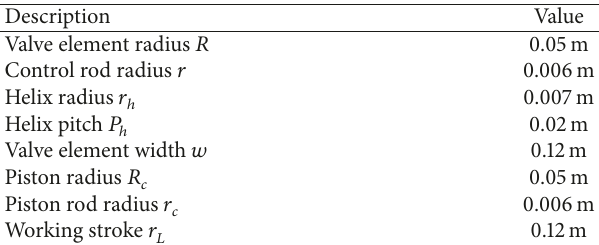
Table 1: Structural parameters for the continuously adjustable inerter